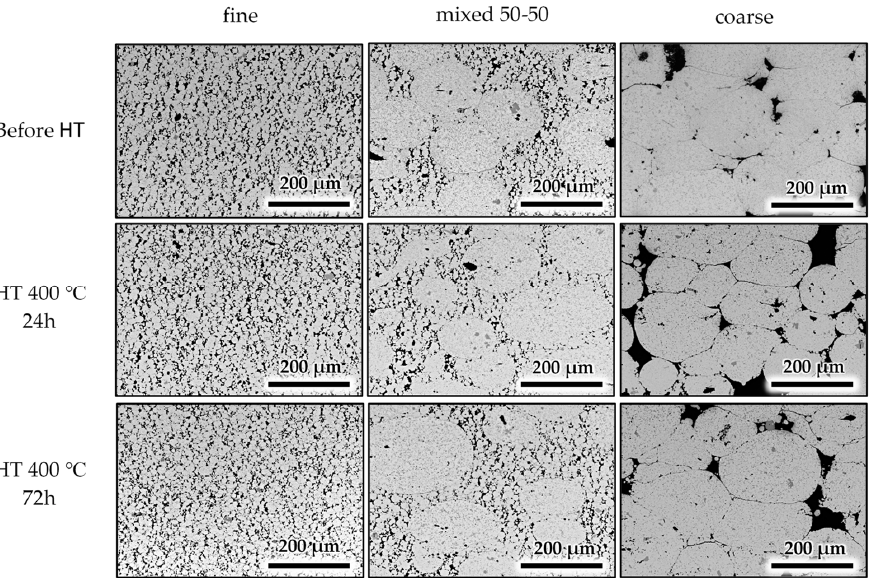
Figure 9. Effects of heat treatment on Al-8Ce-10Mg wt % fine, mixed 50-50, and coarse powder com- posites prepared by PIT.